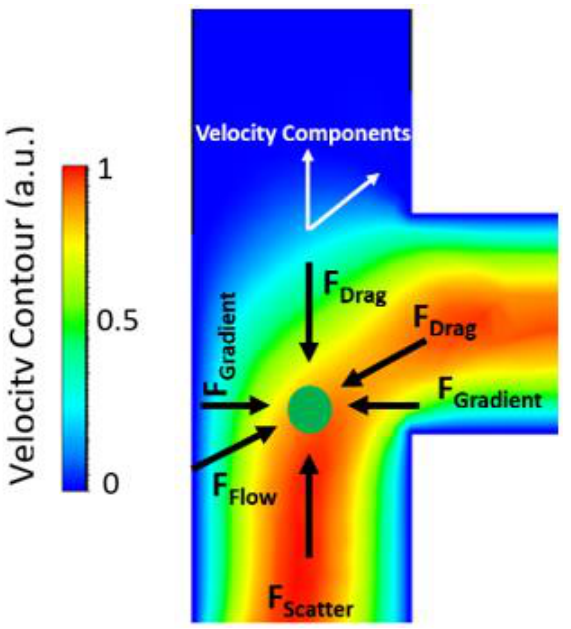
Figure 9. Illustration of forces acting on a particle in the optofluidic region at the channel bend simulated in Ansys Fluent. The scattering force direct the particle towards the protrusion cavity while the gradient force contains the particle in the center of the channel. The fluid velocity tries to pull the particle out of the optofluidic region. The color spectrum demonstrates various fluid velocities with red being fast and blue being slow.